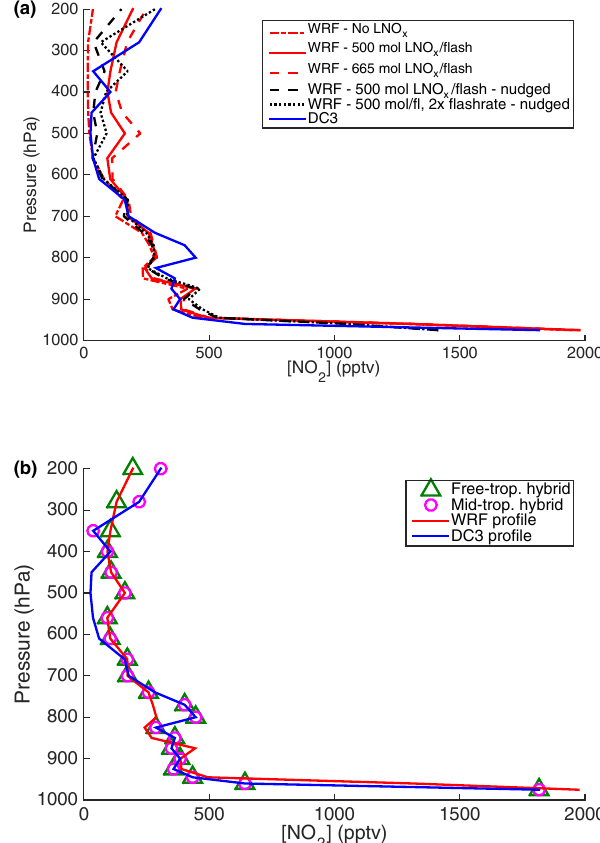
Figure 5. (a) Comparison of the NO 2 profiles obtained from bin- ning all DC3 data and WRF-Chem output along the DC3 flight track (Sect. 2.3) to pressure bins centered on the pressure the scat- tering weights are defined at. (b) The binned DC3 and WRF-Chem (500molflash − 1 , no nudging) profiles; green triangles mark pres- sure levels from each profile used in the free-troposphere hybrid profile, and magenta circles mark pressure levels used in the mid- troposphere hybrid